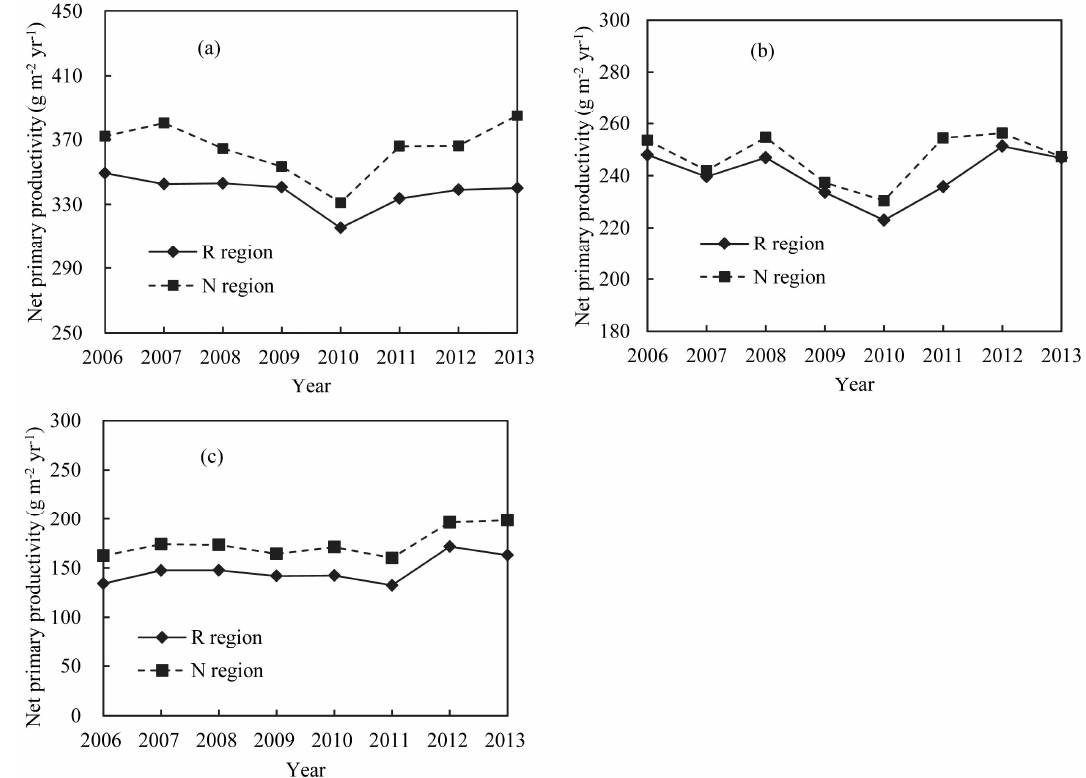
Figure 3. Net primary productivity of forested lands ( a ); woody grasslands/bushlands ( b ); and grasslands ( c ) in regions N and R .